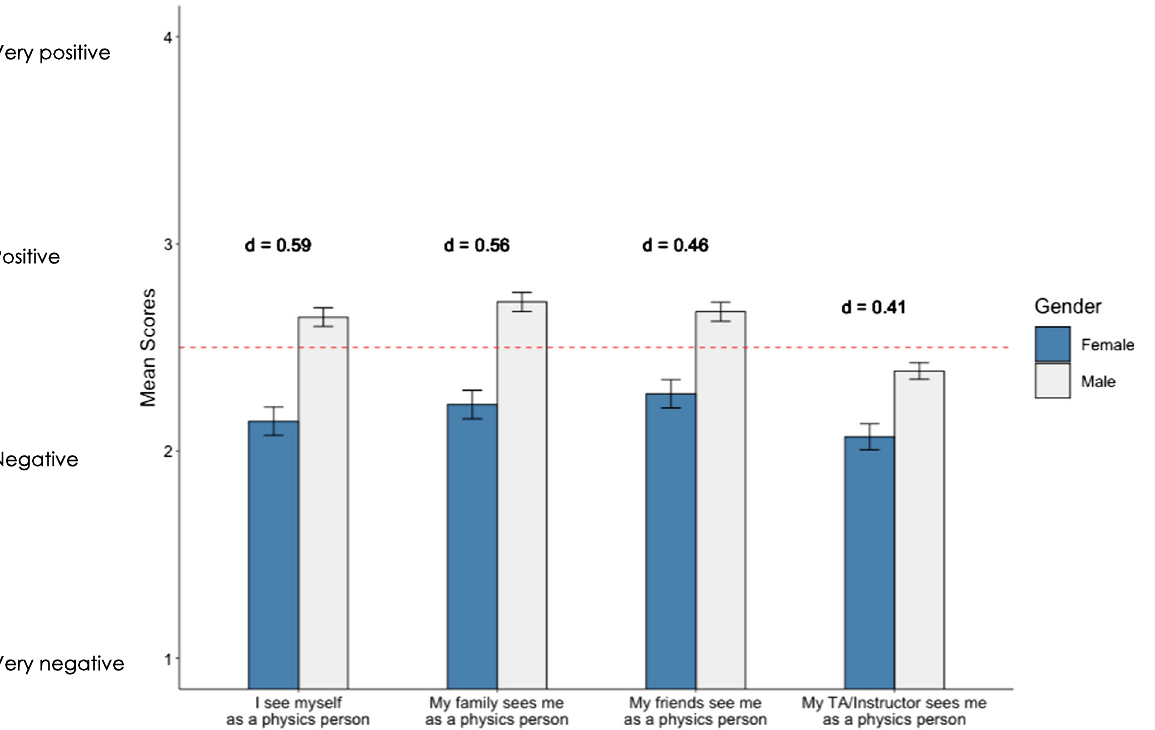
FIG. 2. Mean scores (with standard error bars) for each physics identity item for female and male students. All of the gender differences are statistically significant at the level of p < 0 . 001 . “ d ” denotes Cohen ’ s d for the gender contrast. Red dotted line indicated the score of 2.5, which corresponds to neural response for